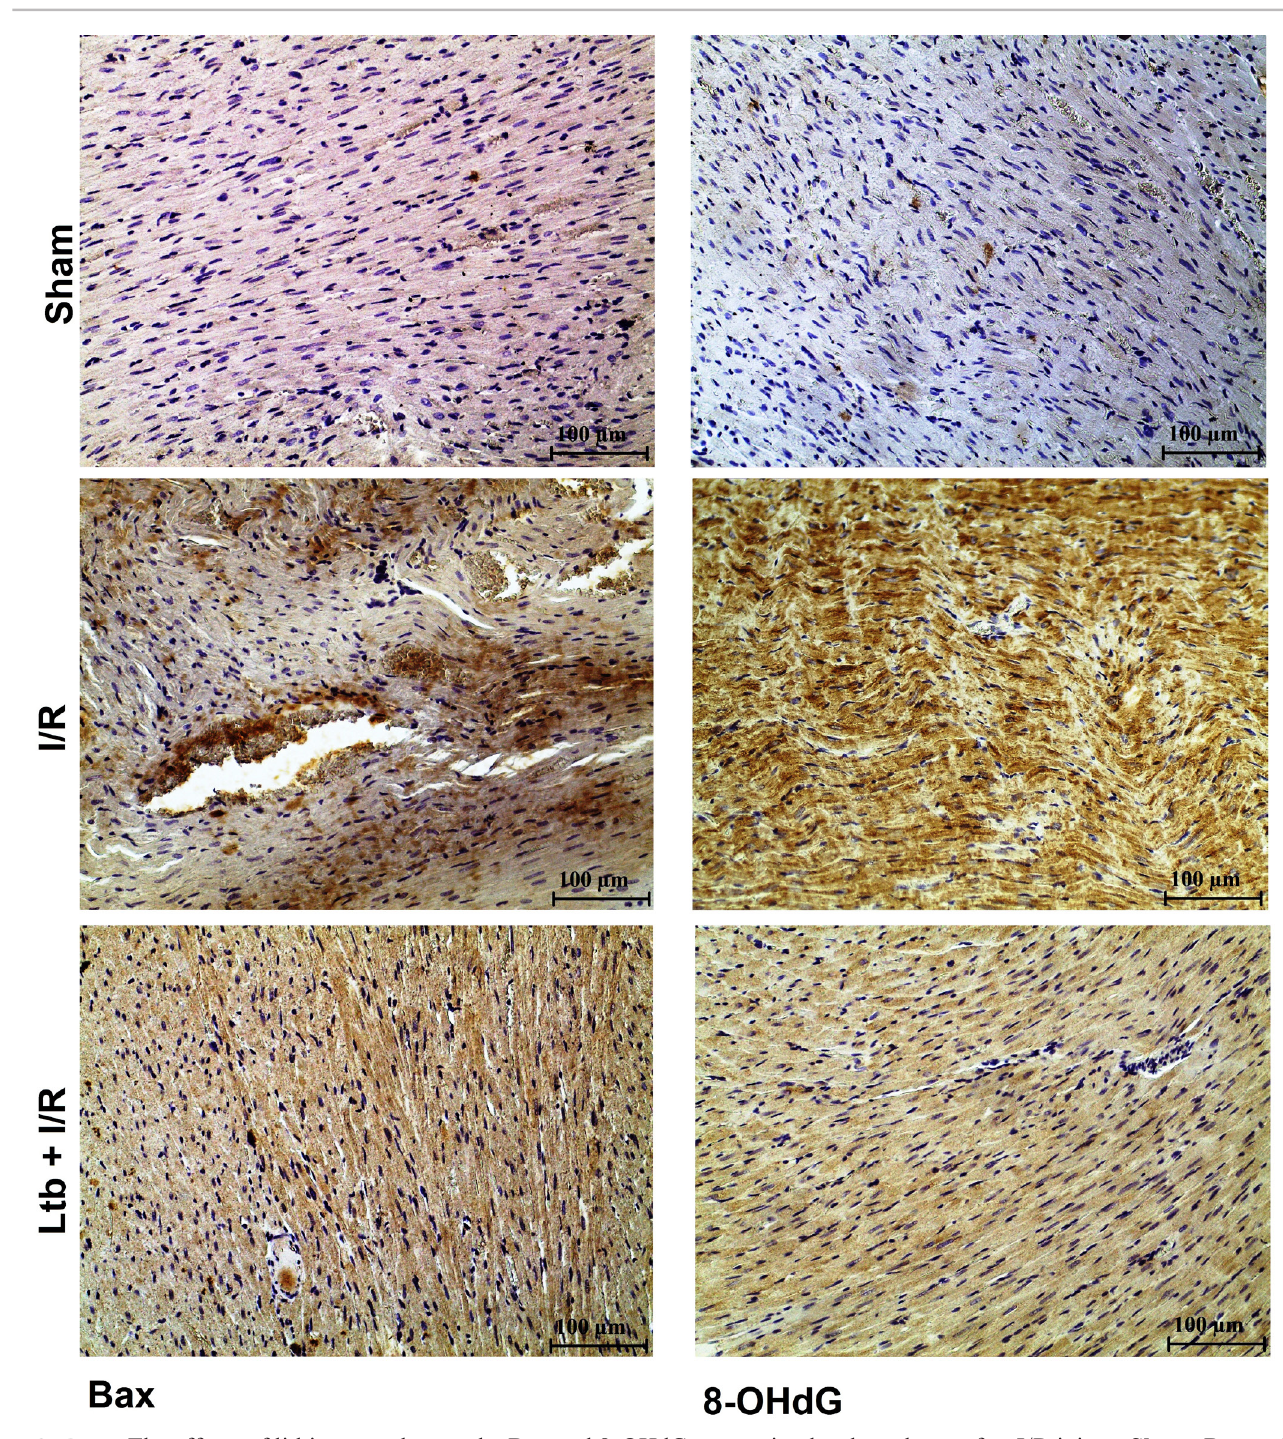
FIGURE 3 - The effects of lithium tetraborate the Bax and 8-OHdG expression levels on heart after I/R injury. Sham ; Bax and 8-OHdG negative, I/R ; severe Bax and 8-OHdG expression, Ltb + I/R ; weak Bax and 8-OHdG immunoreactivity. Abbreviation used: I/R: Ischaemia/Reperfusion, Ltb: Lithium